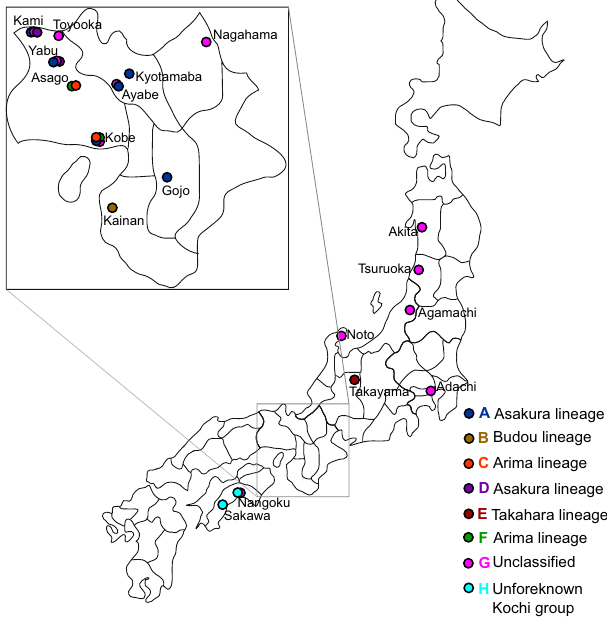
Figure 2. Sampling points and locations of the lineages. The colour scheme is the same as in Fig.